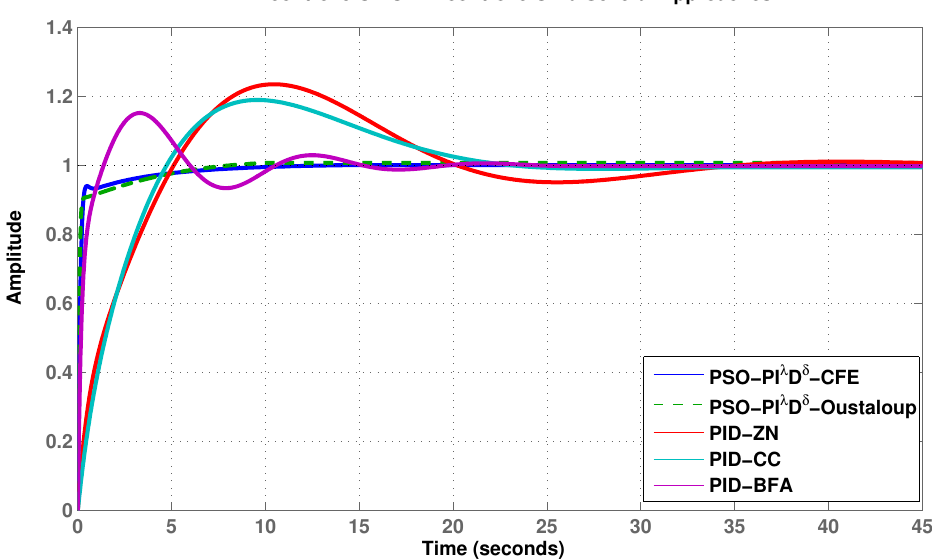
Figure 2. Step responses of H 1 ( s ) , H 2 ( s ) , H 3 ( s ) , H 4 ( s ) and H 5 ( s )